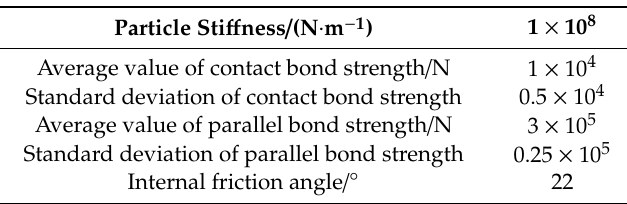
Table 4. The bond Table 4. The bond parameters.